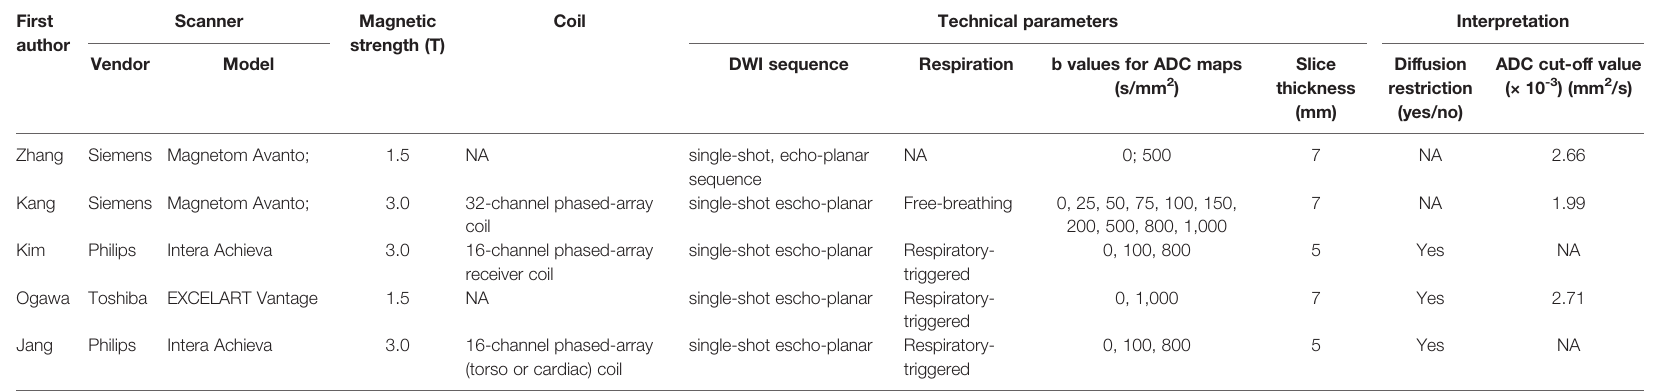
TABLE 2 | MRI characteristics of the included